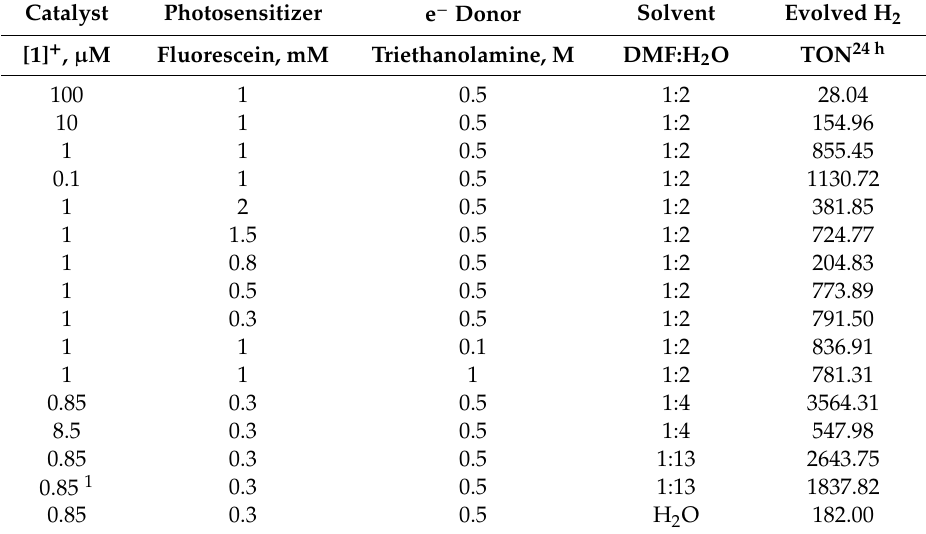
Table 1. Performance of the photocatalytic system under various conditions.